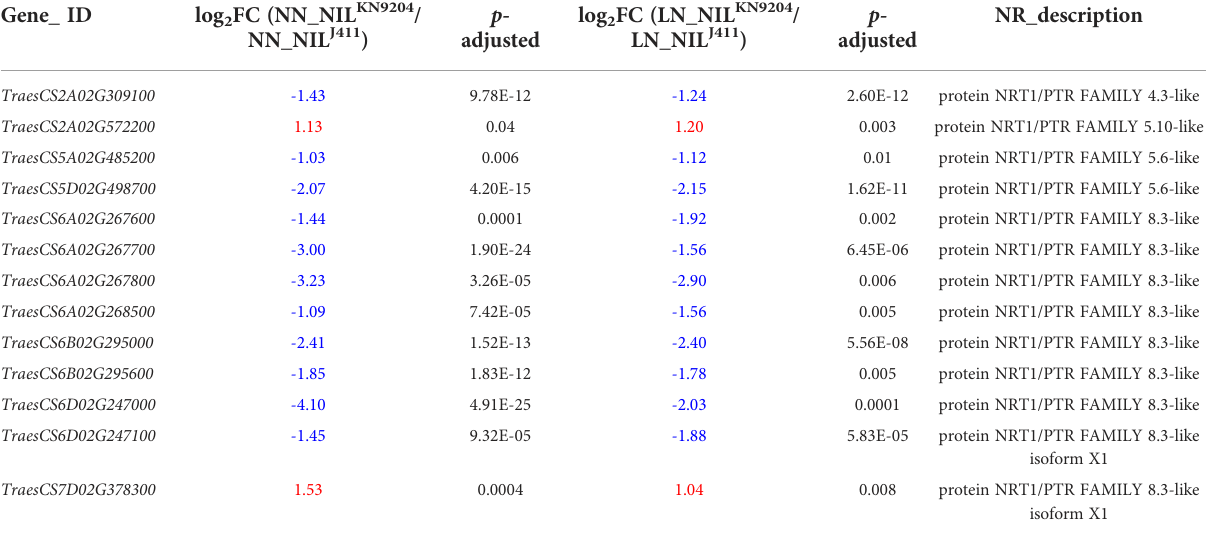
TABLE 3 Differentially expressed NRT genes between the pairwise NILs.